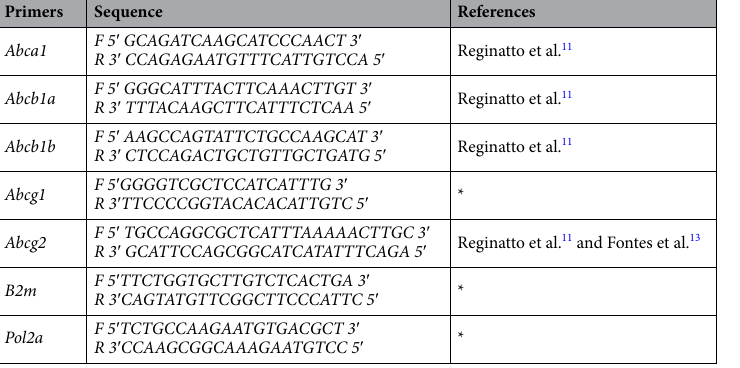
for Medical Research and the U.S. National Academy of Sciences Guide for the Care and Use of Laboratory Animals. All experiments were performed in accordance with ARRIVE guidelines (https:// arriv eguid elines. org). C57Bl/6 J mice were housed in a temperature-controlled room (23 °C), under a 12/12 h light/dark cycle, and had free access to fresh food and water. Female mice aged between 8 and 10 weeks were mated overnight with male mice at a ratio of 2–3 females to each male. After 12 h, the males were removed from the cages, and if the vaginal plug was present, this day was considered as gestational day (GD) 0.5. The confirmation of pregnancy was performed by measuring the weight gain between GD0.5 and GD13.5. Weight gain of 3 g or more confirmed pregnancy. Once pregnant, dams were randomly distributed in experimental groups. For placental and fetal analysis (Fig. 1A), an intraperitoneal injection (ip) of poly(I:C) (Sigma Aldrich, Germany; Catalog Number P1530; lot #114M4028V), dissolved in 100 μL of sterile phosphate-buffered saline (PBS), was administered at a dose of 10 mg/kg at GD13.5 (n = 8). This gestational day was chosen since the murine placenta is fully formed on GD10.5. Furthermore, GD13.5 is somewhat equivalent to the first trimester of human pregnancy. Animals from the control group (n = 8) received an ip injection of the vehicle (100 μL of sterile PBS) at the same day. Maternal blood was collected through the caudal vein after 4 h of the treatment, centrifuged at 1500 G and the plasma was stored at − 20 °C. At GD 18.5 dams were euthanized with an ip injection of sodium pentobarbital at an overdose of 300 mg/kg. Each dam represents a litter (5–8 pups per litter) and the values of fetal and placental weights cor- respond to the litter mean per group. Placentas and fetuses were weighed, and the placentae closest to the mean weight in a litter were selected for further analysis and cut in half using umbilical cord insertion as reference 58,59 . One-half of the placental disk was frozen in liquid nitrogen for qPCR (n = 8 per group), and the other half was fixed overnight in buffered paraformaldehyde 4% (n = 5 per group; Sigma-Aldrich, Brazil) for protein immu- nostaining analysis. For behavioral tests, a second cohort of 6 vehicles and 6 poly(I:C) treated dams were allowed to deliver spontaneously. Here, each dam also represents a litter (5–8 pups per litter) and all newborns in the litter were evaluated per group. The resulting offspring were nursed by their dams until postnatal day (PND) 21. After weaning, they were housed under the same maternal conditions until the behavioral tests were performed at PNDs 54, 93 and 96. Total placental RNA was extracted from 8 placentas from each group, using the TRIzol method according to the manufacturer’s instructions (TRIzol Reagent; Life Technologies, USA). The concentration of total RNA was assessed using NanoPhotometer (Implen, Munchen, Germany) and samples with RNA purity (260/280 absorbance) ratio ranging between 1.8 and 2.0 and with proven RNA integrity (confirmed through gel electrophoresis) were included in the study. Total RNA (1 μg) was used to synthesize cDNA using the High- Capacity cDNA Reverse Transcription Kit (Applied Biosystems, USA) according to the manufacturer’s instruc- tions. mRNA levels of selected ABC transporters (Table 1) were evaluated by qPCR following the manufacturer’s recommendations (EVAGREEN; Solis Byodine, USA) and using the QuantStudio 3 Real-Time PCR System (Thermo Fisher, USA), with the following cycling conditions: combined initial denaturation at 50 °C (2 min) and 95 °C (10 min), followed by 40 cycles of denaturation at 95 °C (15 s), annealing at 60 °C (30 s) and extension at 72 °C (45 s). For quantification, the LinRegPCR program was used according to Ruijter et al. (2009) 60 . Tests with 95–105% efficiency were considered acceptable. Samples that did not pass in the quality checks of LinReg soft- ware (no amplification, no plateau, PCR efficiency outside 10%, excluded from mean Eff) were removed from the analysis. The reference genes were chosen according to their Cq values and variances between the groups. Gene expression was normalized to the geometric mean of reference genes, B2m and Pol2a , which exhibited stable expression levels following poly(I:C) insult. DNA contamination was ruled out using intron-spanning primers, reverse transcriptase-negative samples and melting curve analyses obtained from each qPCR reaction. All samples and standards were measured in duplicate. Histological, immunohistochemical and TUNEL analysis. Five fixed placentas from 5 pregnancies of each group were processed following a protocol with increasing concentrations of ethanol (Isofar, Brazil),